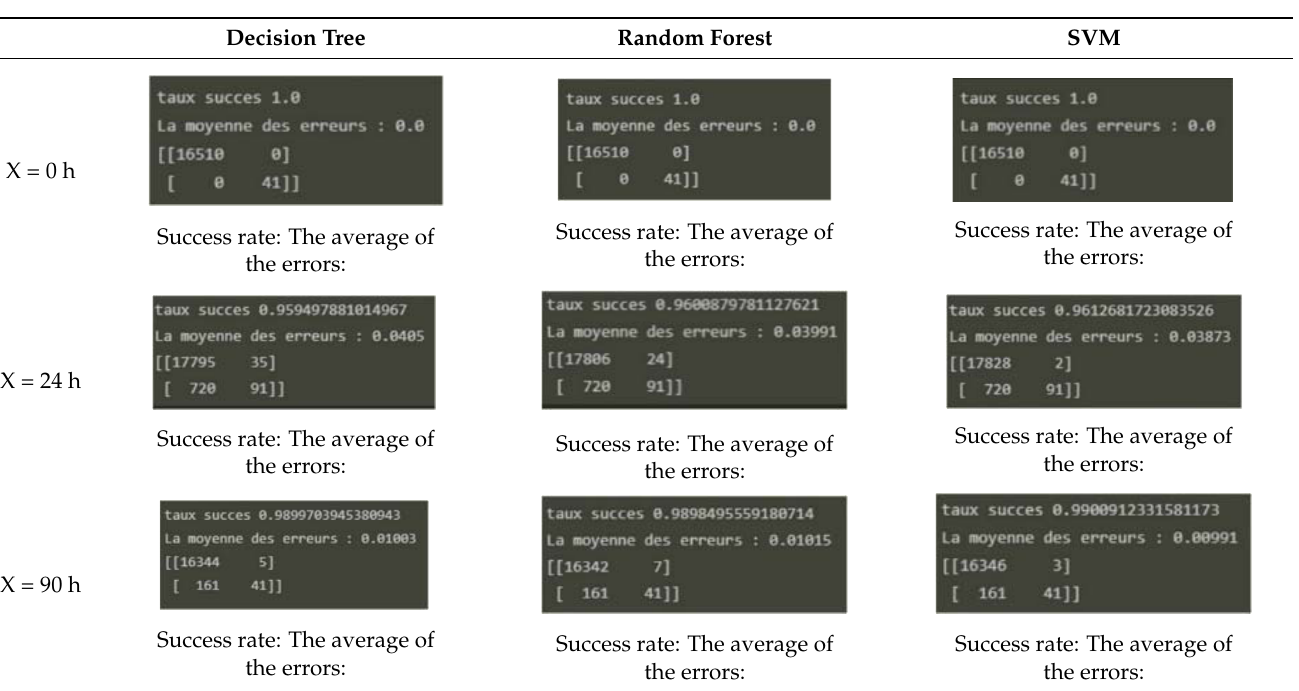
Table 4. The results of the prediction by fixation of 90 h, 24 h, and 0 h before the failure (example of discrete cluster 1) for the three algorithms .